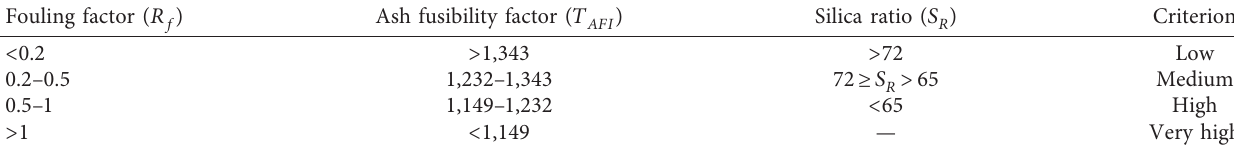
Table 2: Recommended values for the evaluation of fouling factor, ash fusibility factor, and silica ratio.